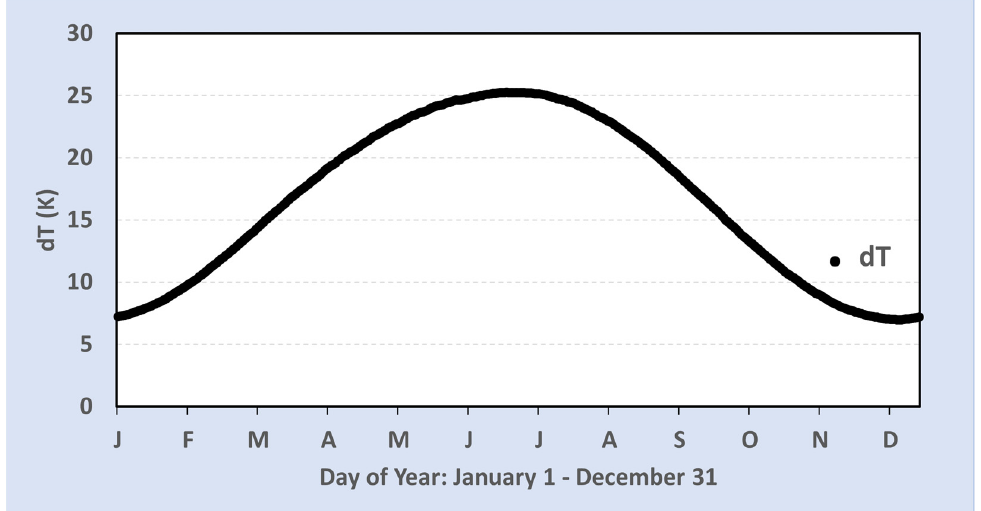
Figure 3. Timeseries of dT (climatology) for the study region (gray area in Figure 2) showing seasonal evolution that mimics net radiation patterns of the region. Time series represents the period from 1 January through 31 December of a given year.